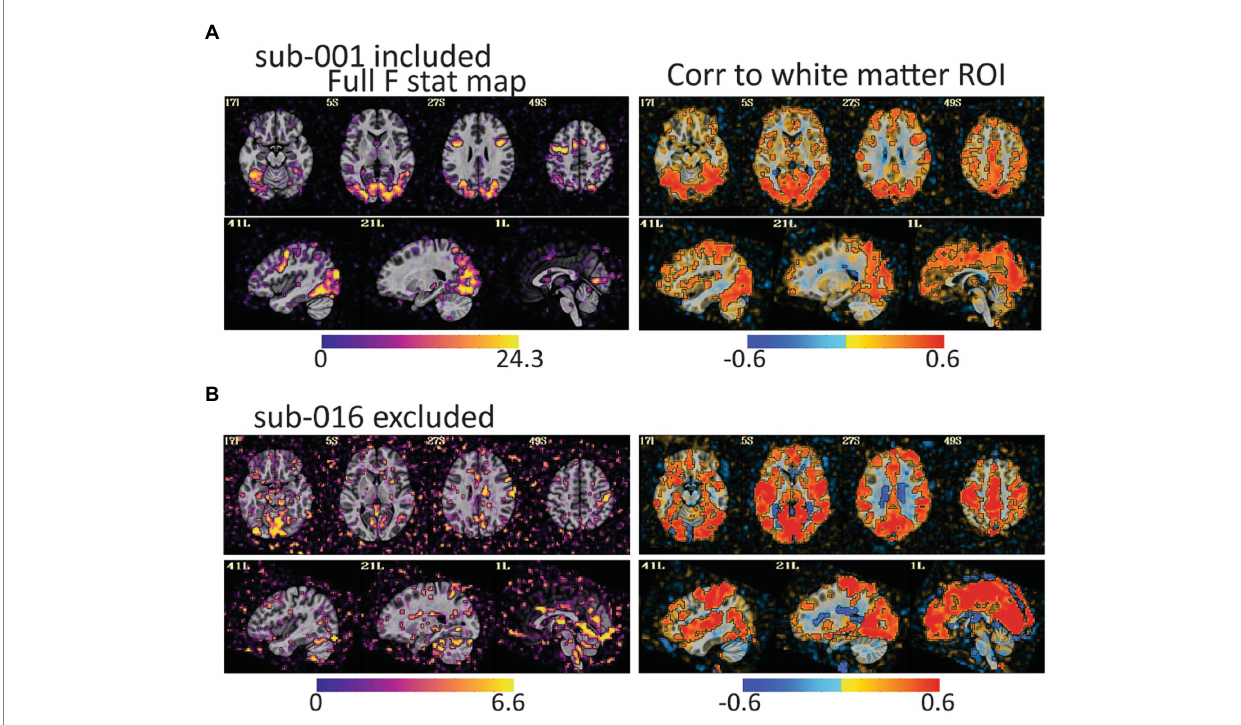
FIGURE 4 The full F stat map shows the decile of voxels with the highest F values for the full task GLM. The correlation to the white matter ROI shows voxels that correlated to white matter after the task design is regressed from the data. (A) For sub-001\u00B0F stat peaks are large and mostly in gray matter. (B) For sub-016, the F values are smaller, and the peaks are in lateral ventricles, CSF, and outside of the brain. The white matter correlation maps are harder to identify as clearly good or bad, but more pervasive correlations to gray matter as in (B) are an additional warning of a problem. Notably, both subjects have